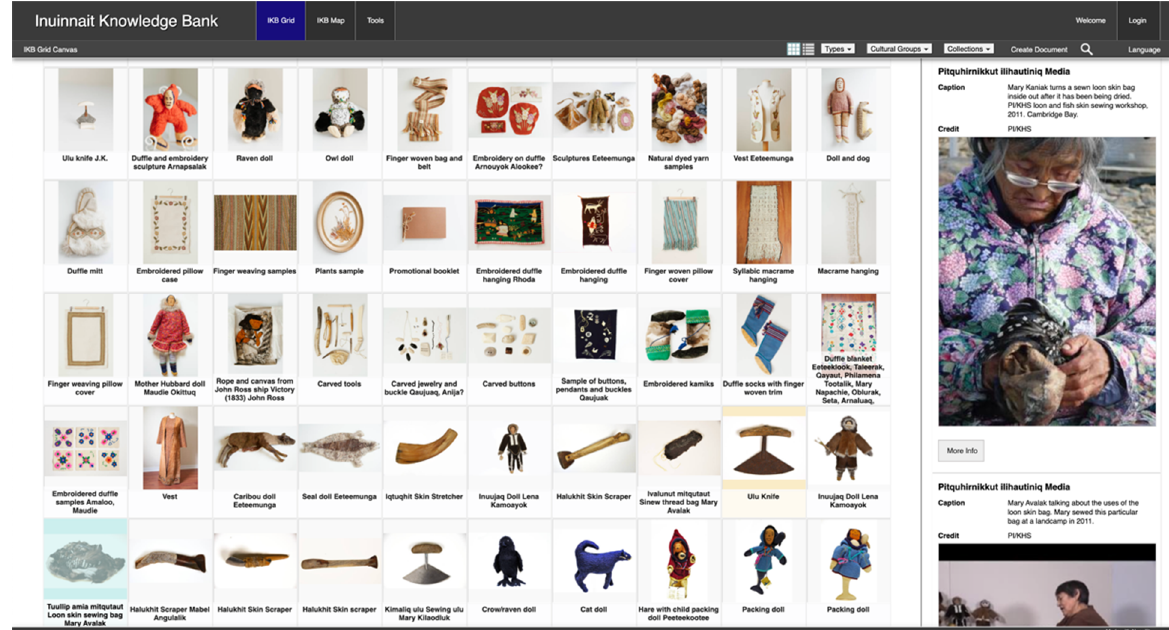
Figure 9. Community submitted records about a loon skin bag help to better position collections within a cultural context. The multiple videos seen to the right of the screen demonstrate a loon bag’s manufacture techniques, Inuinnaqtun terminology, and a host of related information regarding everything from harvesting techniques for loons to cultural prescriptions for materials that should be carried within such a bag.